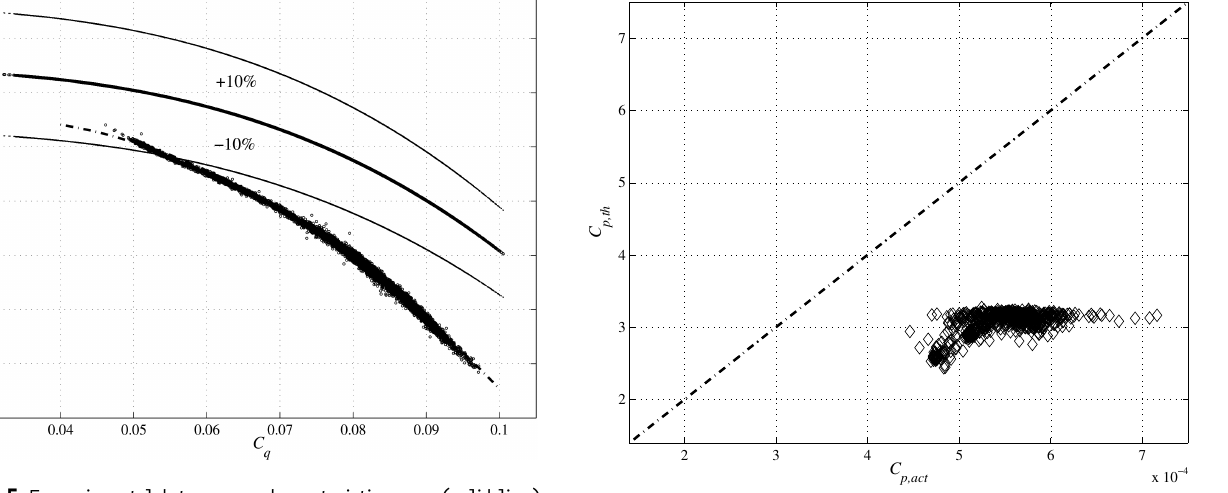
Figure 5. Experimental data, pump characteristic curve (solid line) and the fitting (dashed line) made by Eq. (5) plotted in the C q - C h plane (thinner solid lines define the band of confidence given by the manufacturer).